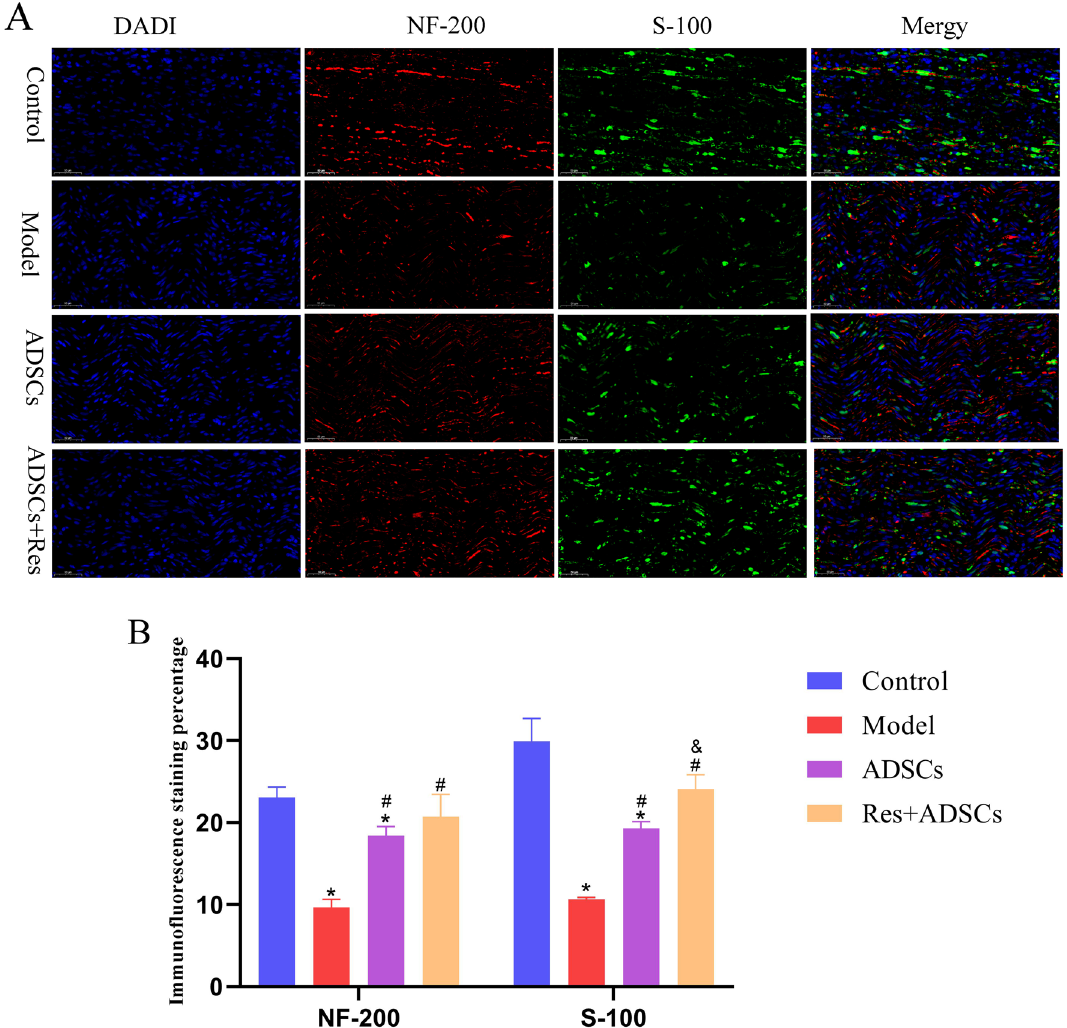
Figure 10. Effect of Res preconditioned ADSCs on S-100/NF-200 expression after sciatic nerve injury in rats. ( A ) Sciatic nerve S-100 /NF-200 immunofluorescence double standard staining; ( B ) Immunofluorescence staining percentage; * Indicates a significant of difference compared with control group, P < 0.05, n = 5. # Indicates a significant of difference compared with the model group, P < 0.05, n = 5 and Indicates a significant of difference compared with the ADSC group, P < 0.05, n = 5. Scale bar: 50